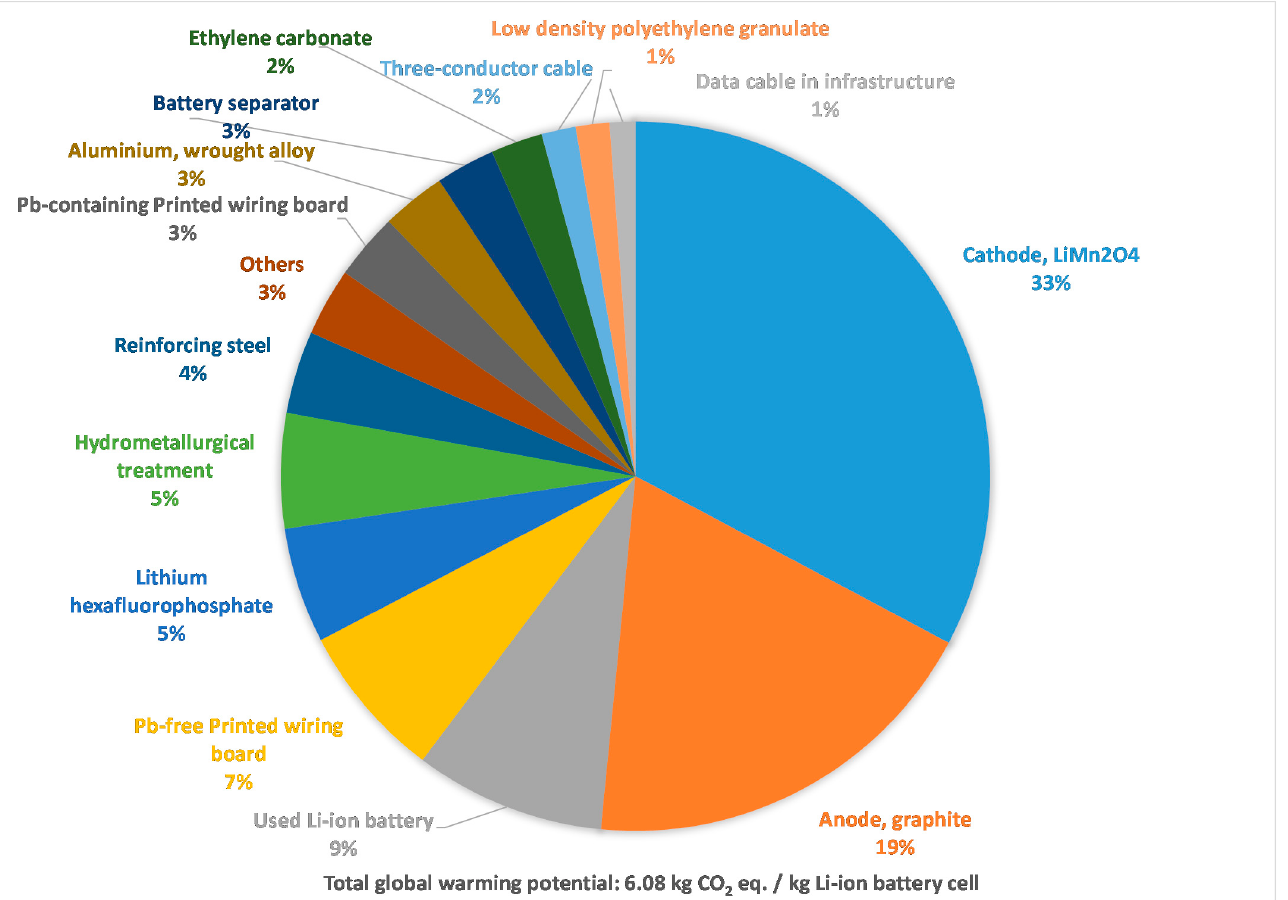
Figure 4. Results of GWP hotspot analysis of BESS.